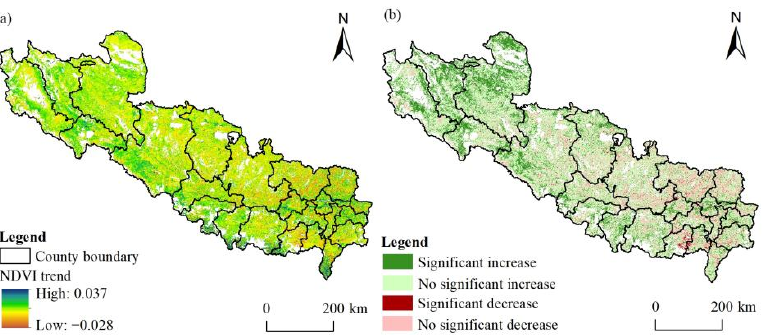
Figure 4. NDVI variation trend ( a ) and significance test ( b ) in the SWTP from 2000 to